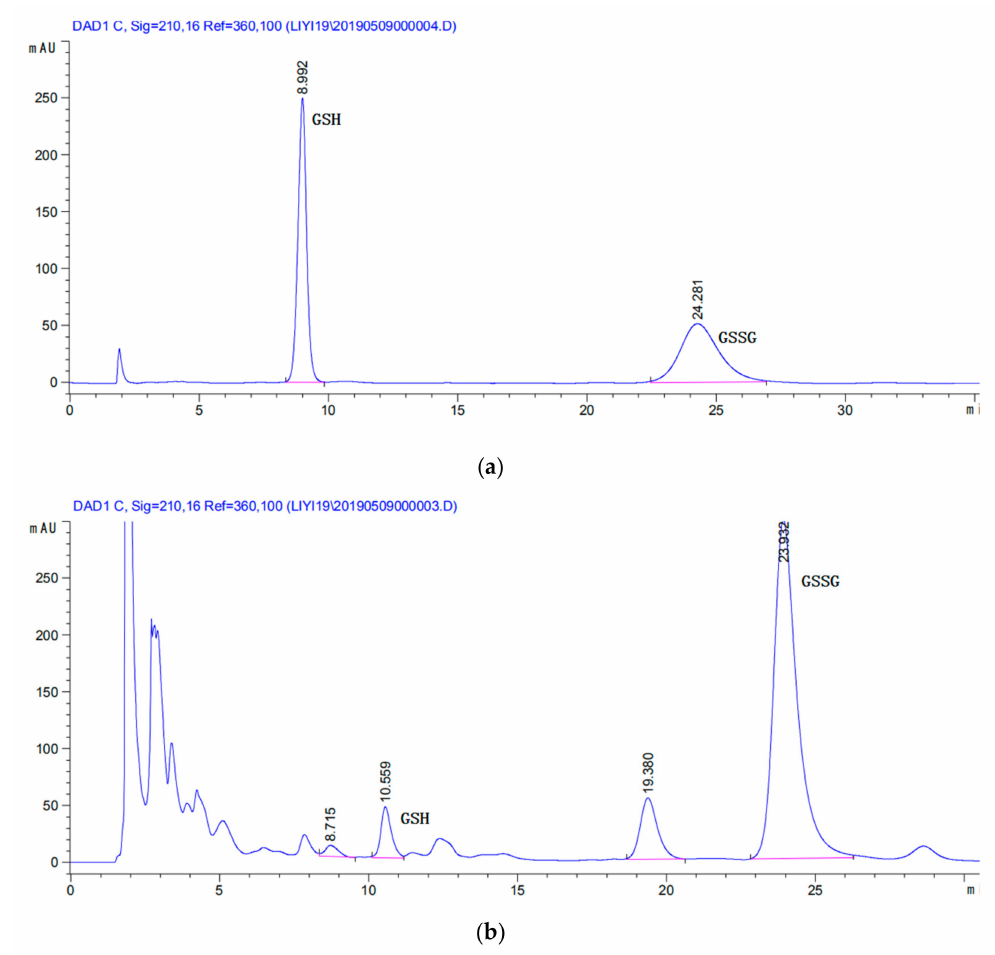
Figure 5. Glutathione analysis by HPLC. ( a ) analysis of GSH and GSSG standards by HPLC; ( b ) analysis of GSH and GSSG samples by